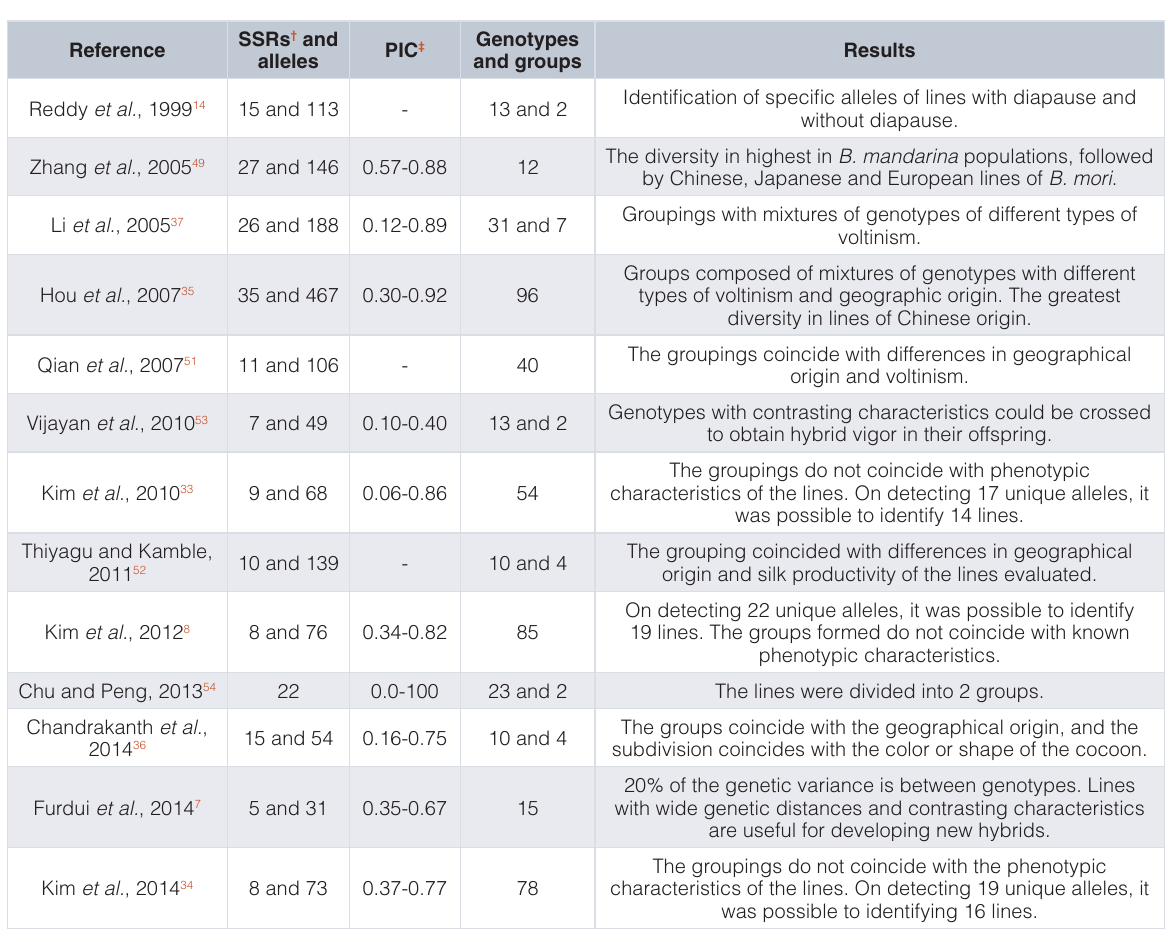
Table 1. Studies of genetic diversity conducted in B. mori using